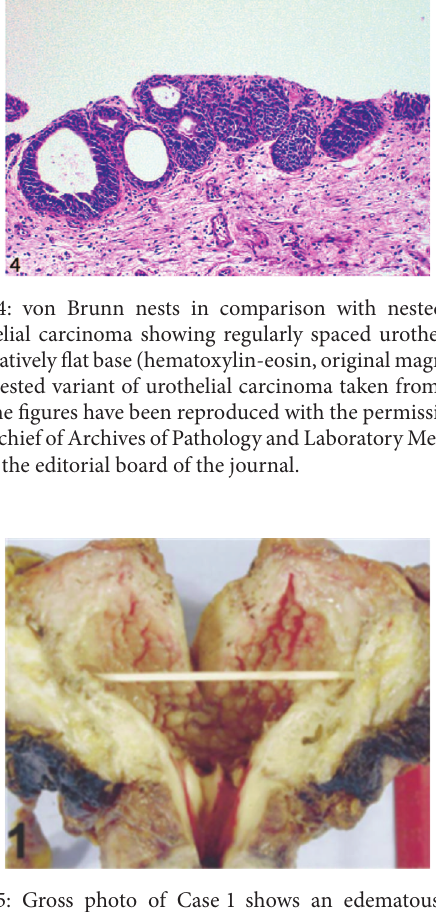
Figure 5: Gross photo of Case 1 shows an edematous urinary bladder mucosa and markedly and diffusely thickened bladder wall Xiao et al. [28].